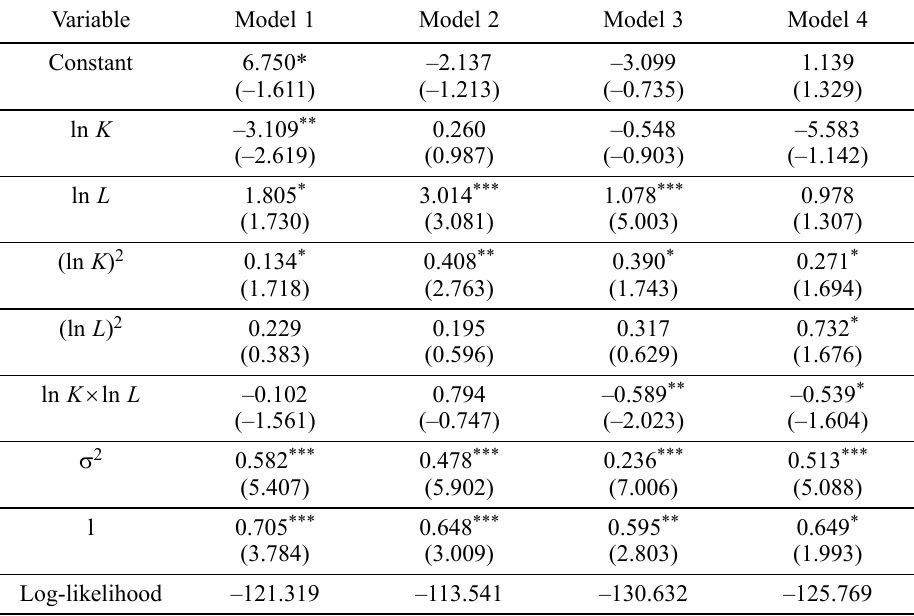
Table 2. Results of the stochastic frontier